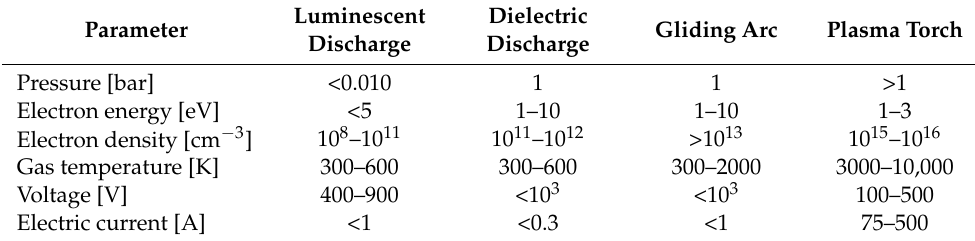
Table 1. Typical plasma parameters generated by electrical discharges. Parameter